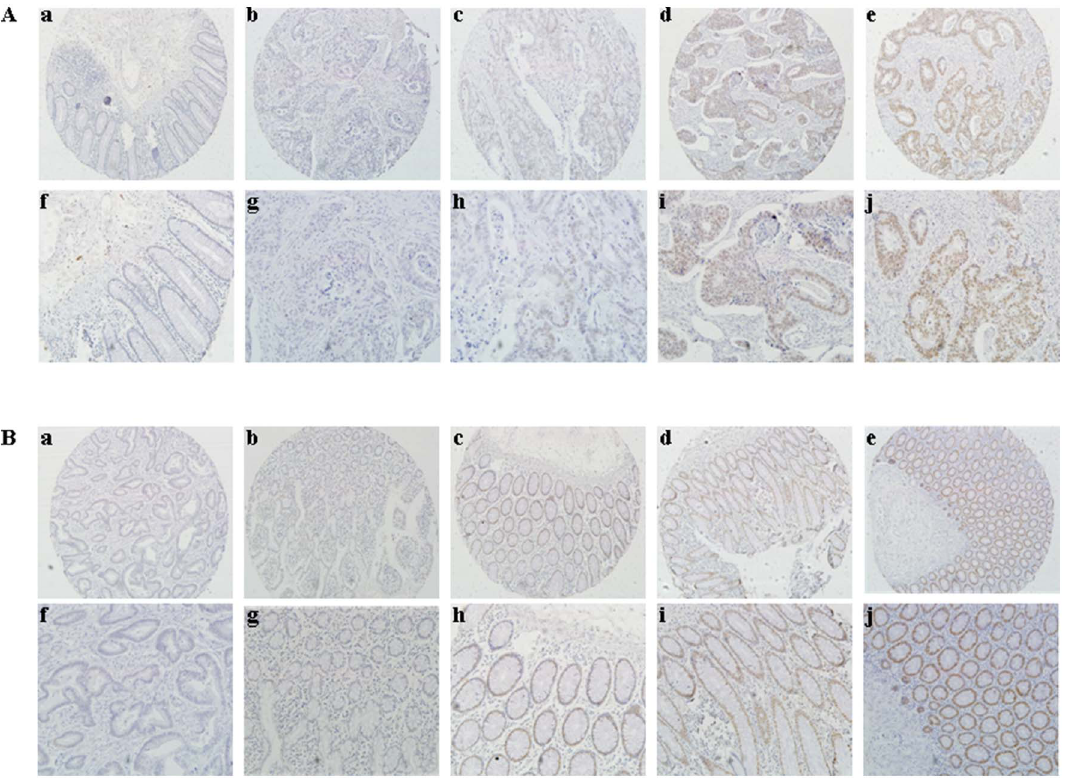
Figure 7. Representative immunohistochemical staining of SATB1 and SATB2 in colorectal cancer and matched normal mucosa. (A) Images ( 6 100) representing immunohistochemical staining of SATB1 in (a) normal mucosa and colorectal cancer, ranging from (b) negative (c) weakly positive (d) moderately positive (e) strongly positive nuclear intensity. (f)/(g)/(h)/(i)/(j): Higher magnifications of panel a/b/c/d/e (magnification 6 200). (B) Images ( 6 100) representing immunohistochemical staining of SATB2 in (a) colorectal cancer and normal mucosa, ranging from (b) negative (c) weakly positive (d) moderately positive (e) strongly positive nuclear intensity. (f)/(g)/(h)/(i)/(j): Higher magnifications of panel a/b/c/d/e (magnification 6